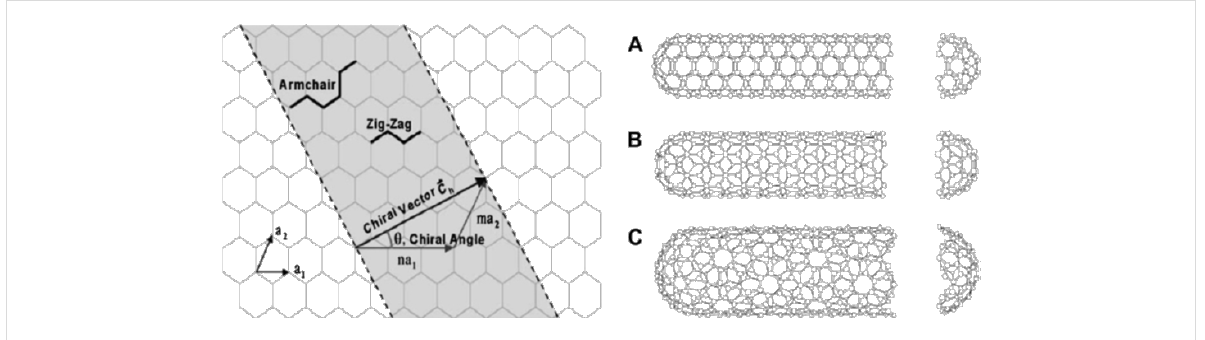
Figure 4: Schematics of graphene sheets rolled to form CNTs with different conformations (A: armchair, B: zigzag, C: chiral). Reproduced with permission from: left panel [42], copyright 2001 Elsevier; right panel [43], copyright 1995 Elsevier.